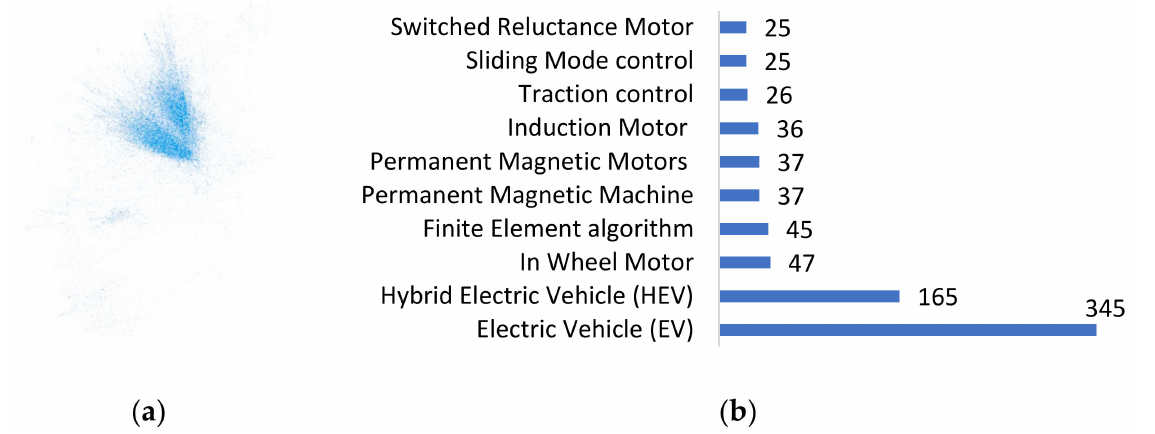
Figure 9. Representation of the energy-efficient transmission in EVs community: ( a ) isolated distribu- tion of publications; ( b )